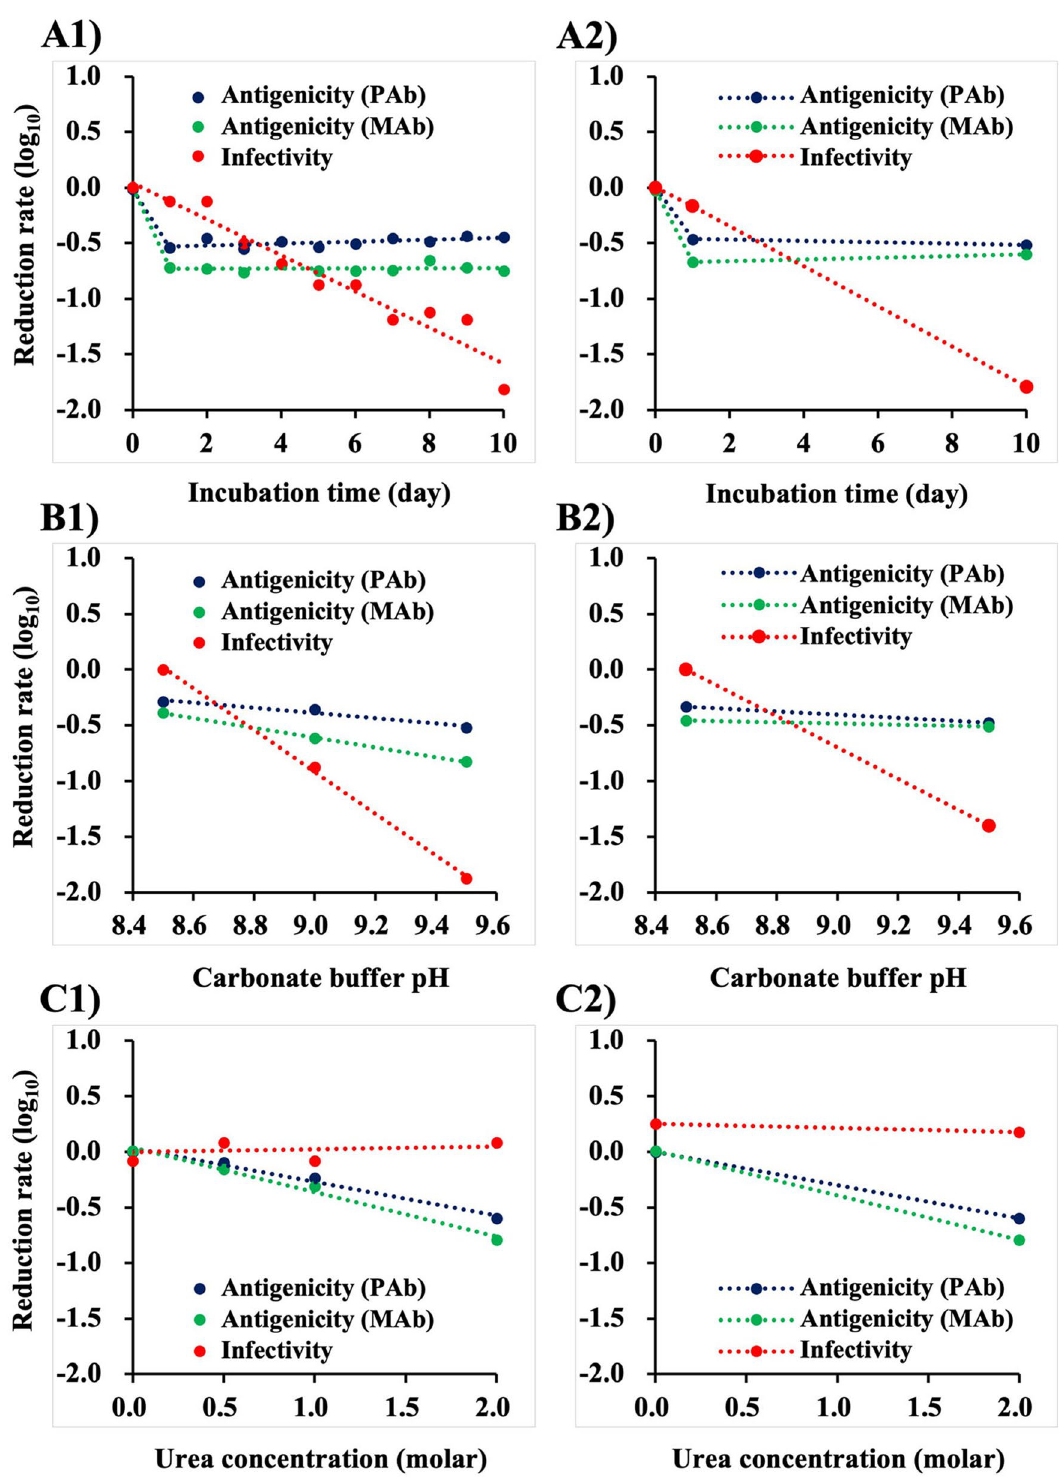
Figure 4. Comparison of declination patterns among NNV antigenicity and infectivity. The declination rate against control (treatment with DIW) were recalculated and are shown in semi-logarithmic graphs. ( A ) NNV incubated in PBS at 37 °C, ( B ) NNV treated with carbonate buffers at different pHs ranging from 8.5 to 9.5, ( C ) NNV treated with different concentration of urea (0 to 2.0 M). (1) Based on the results of a single set of experiments, (2) based on the reproducibility tests with five separate